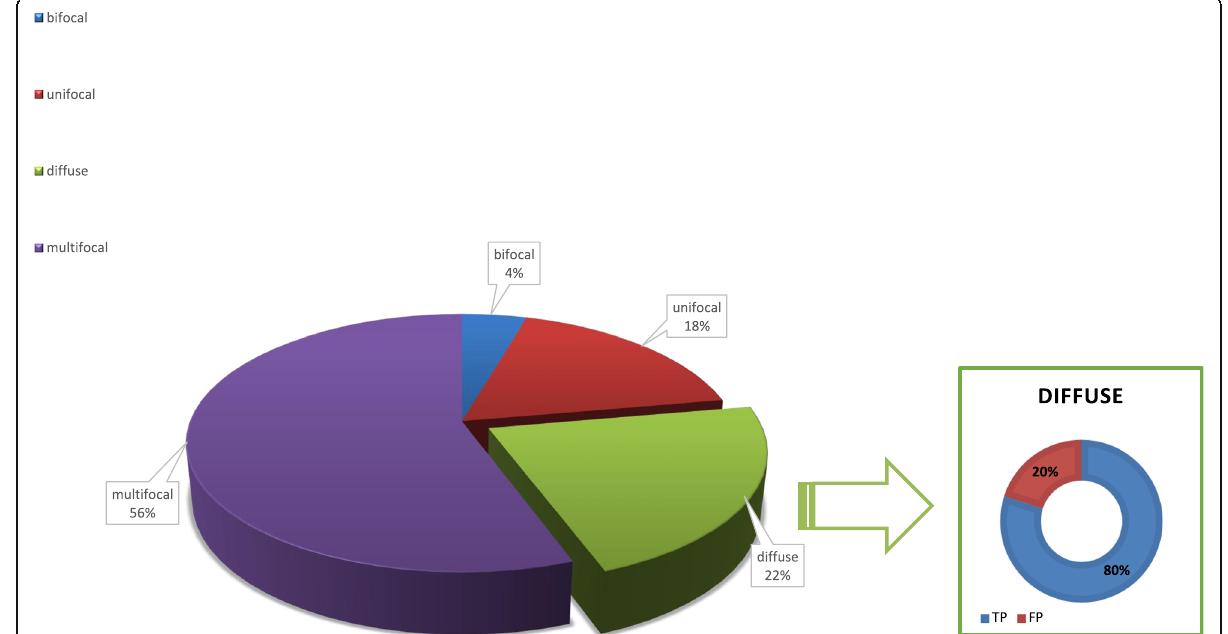
Fig. 3 Bone marrow infiltration in